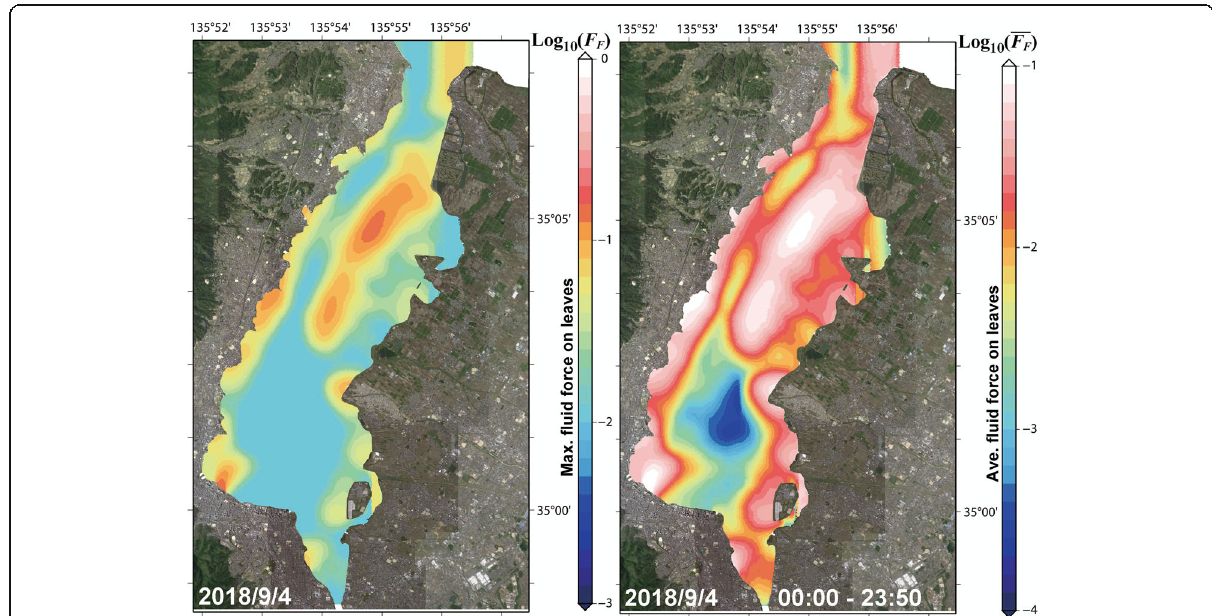
Fig. 15 Maps of the maximum (left) and time-averaged (right) fluid forces acting on the submerged macrophytes during the period of 0:00 –